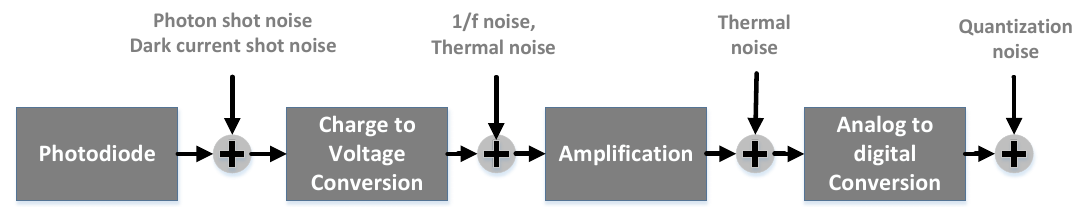
Figure 3. Noise model of CMOS image sensor (adapted from